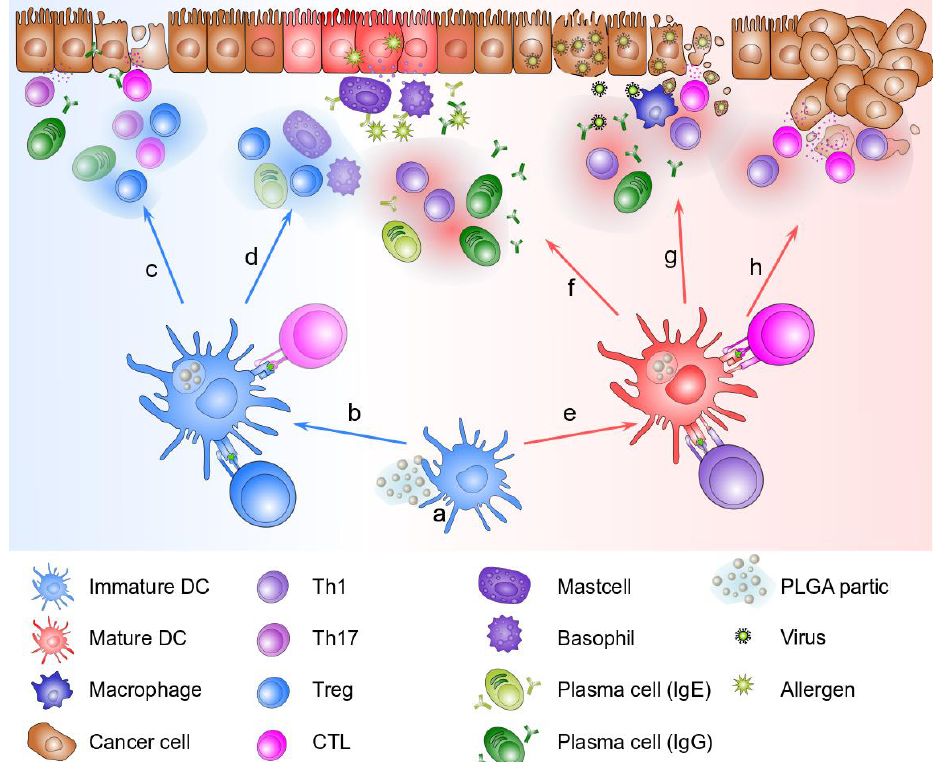
Figure 4. Schematic overview of PLGA particle vaccinations. PLGA vaccines taken up by immature dendritic cells ( a ). Co-delivery of tolerogenic adjuvants leads to antigen presentation on MHC class I and II in the absence of co-stimulatory signals and subsequently promotes anergy in T cells and induces Tregs ( b ). Tregs can silence autoreactive immune responses in AID and re-establish immune homeostasis and peripheral tolerance ( c ). In allergy, Tregs induced by tolerogenic PLGA vaccines can help to ameliorate symptoms via immunosuppression of mast cells, basophils, and effector immune responses such as IgE production by plasma cells ( d ). Upon co-delivery of antigens and immunostimulatory adjuvants, antigen presentation on MHC class I and II, and simultaneous co-stimulatory signaling by DCs to CD4+ and CD8+ T cells elicits potent Th1 biased immune responses ( e ). Th1 mediated SIT induces class switch from IgE to IgG and promotes desensitization in allergic diseases ( f ). Potent protective immunity is achieved by PLGA vaccination resulting in the stimulation of humoral and cellular responses to fight off infectious diseases like viral infections ( g ). PLGA-mediated cancer vaccines can elicit strong Th1 driven cellular immunity capable of tumor eradication by robust CTL responses ( h ).